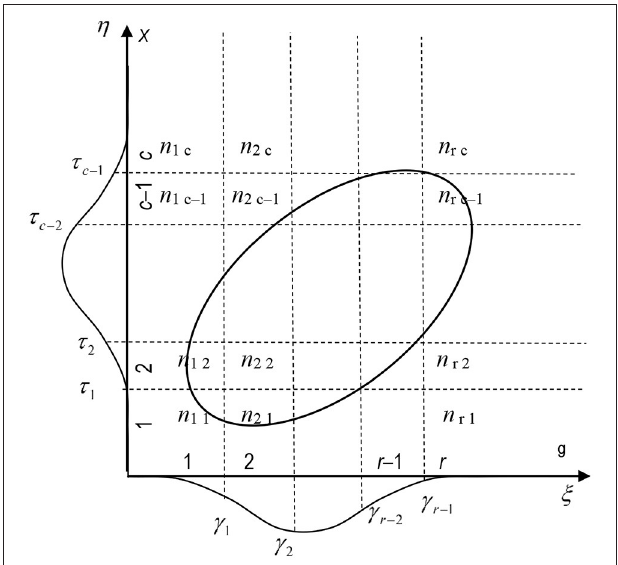
FIGURE 1 | Two latent variables η and ξ manifested as X and g with ordinal or interval scales.